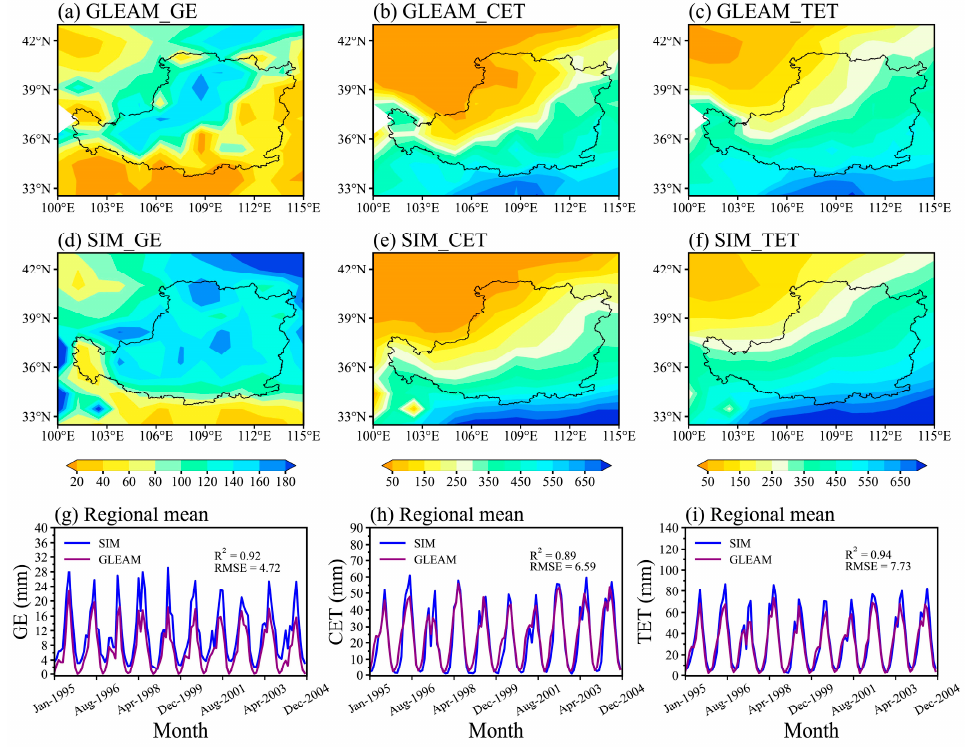
Figure 4. Comparison of the simulated mean annual ET by the CLM and GLEAM-based average values on the LP during 1995–2004. The top row ( a – c ) shows GLEAM-based ground evaporation, canopy ET, and total ET, respectively; the middle row ( d – f ) shows CLM-simulated ground evaporation, canopy ET, and total ET (unit: mm), respectively; and the bottom row ( g – i ) shows the model performance expressed as the R 2 and RMSE values for the area-averaged monthly time series for ground evaporation, canopy ET, and total ET, respectively.